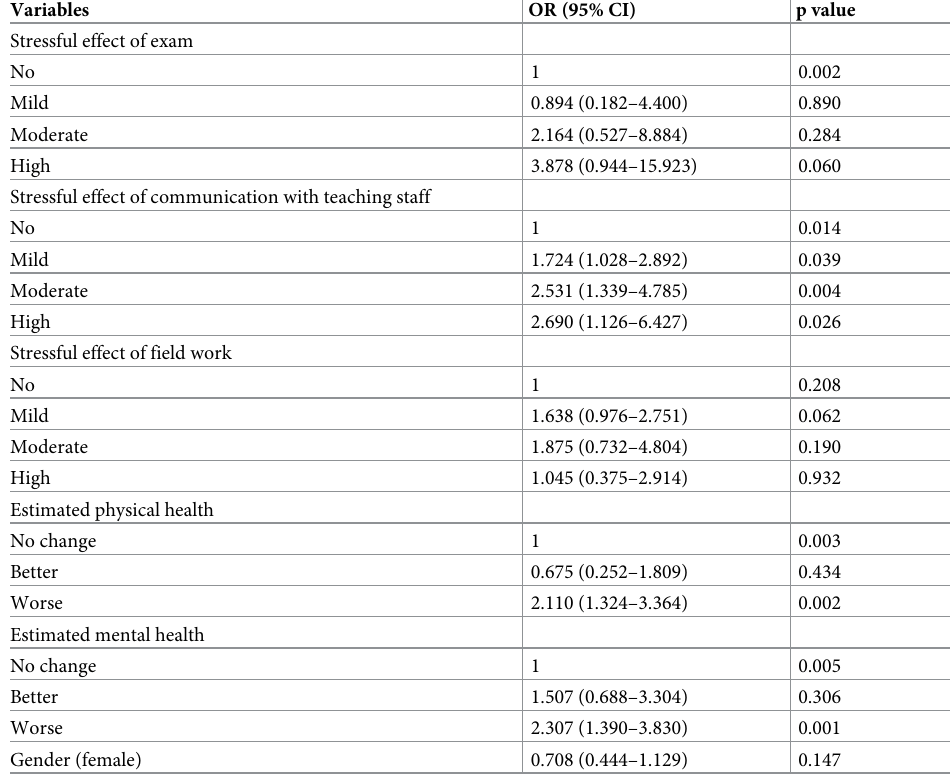
Table 4. Multiple regression model with the presence of burnout as a dependent variable and perceived stress of academic activities as independent